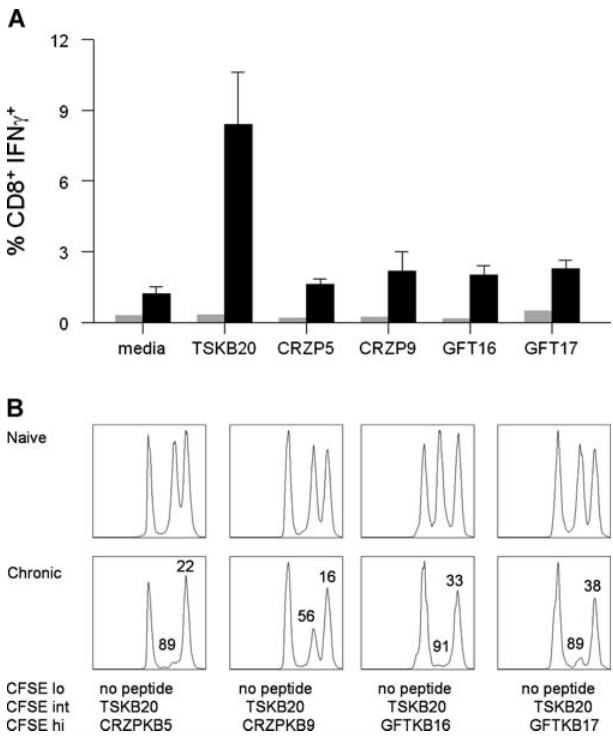
Figure 2. Functional Responses of Murine CD8 þ T Cells Directed against Non-ts Epitopes (A) SCs from naive (gray bars) or chronically infected (Brazil strain; black bars) B6 mice were stimulated for 5 h with TSKB20, cruzipain, or GFT peptides plus GolgiPlug as described in Materials and Methods. Data represent the number of CD8 þ T cells producing IFN c ; error bars represent SD. (B) SCs from naive B6 mice were loaded with T. cruzi peptides and labeled with CFSE as described in Materials and Methods. The numbers above the peaks represent the percentage of specific killing of the target cells loaded with the indicated peptide and was calculated as described in Materials and Methods. Data are representative of three experiments. DOI: (Figure 3C, top right), whereas TSKB20/K b and TSKB21/K b tetramers bind to the same population of T cells (Figure 3C, bottom right). Costaining with TSKB21/K b reduces the intensity of TSKB20/K b fluorescence, whereas costaining with TSKB18/K b does not (Figure 3C, left panel), indicating competition between TSKB21/K b and TSKB20/K b for binding to the same T-cell receptor. TSKB260, which differs from TSKB20 only at the P8 K b anchor residue, also cross-reacts with the TSKB20-specific T-cell population (unpublished data). (For simplicity, the population of T cells responding to